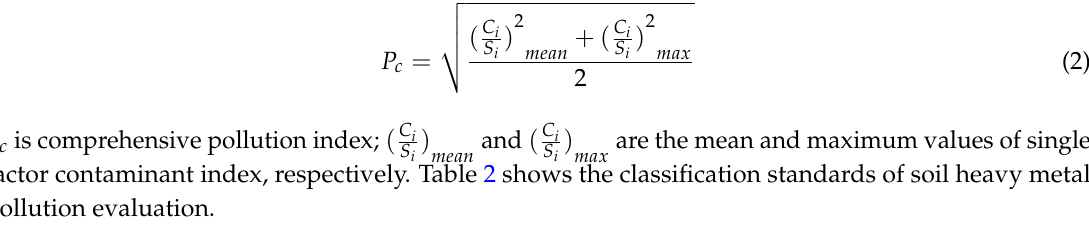
Table 2. Classification standards of soil heavy metal pollution